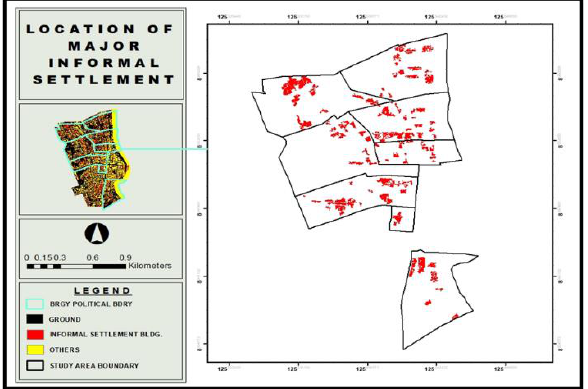
Figure 18. Location of the Major Informal